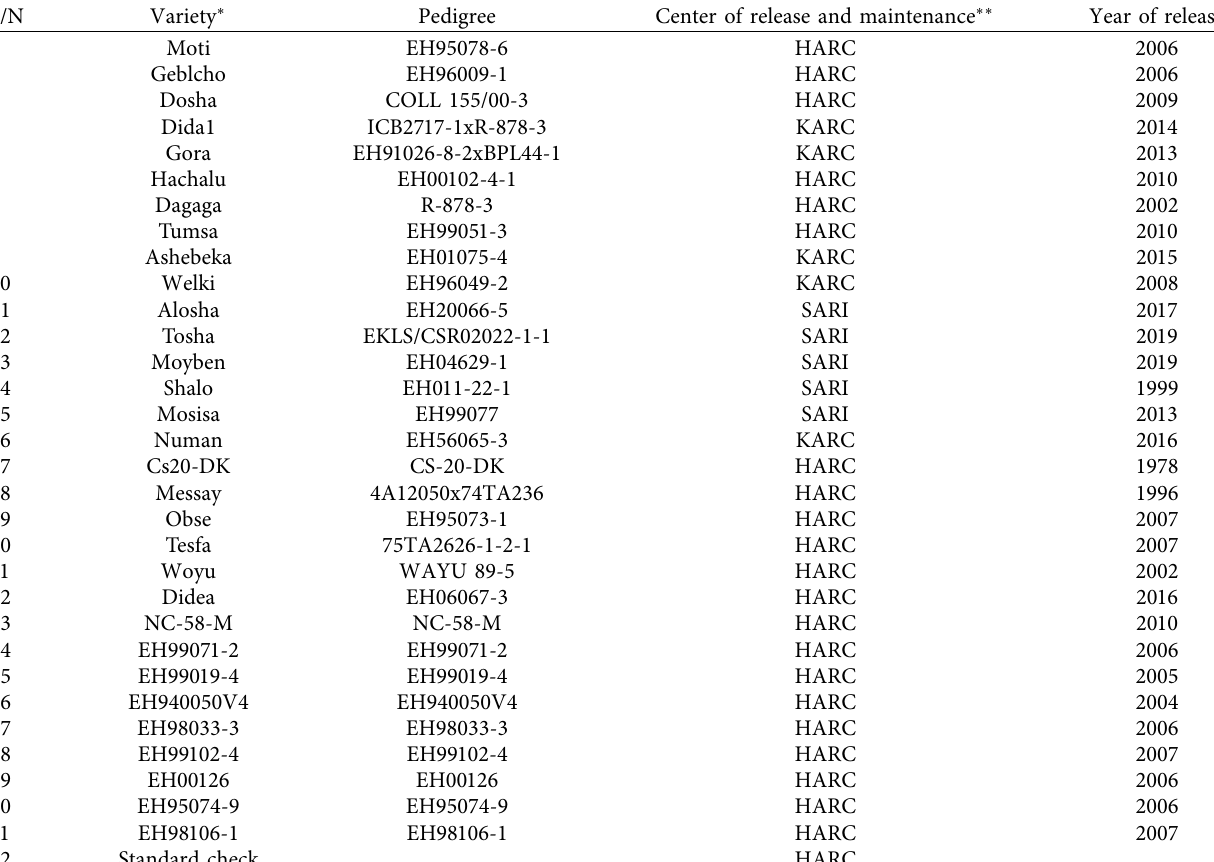
Table 1: Detailed description of the faba bean varieties used in the present